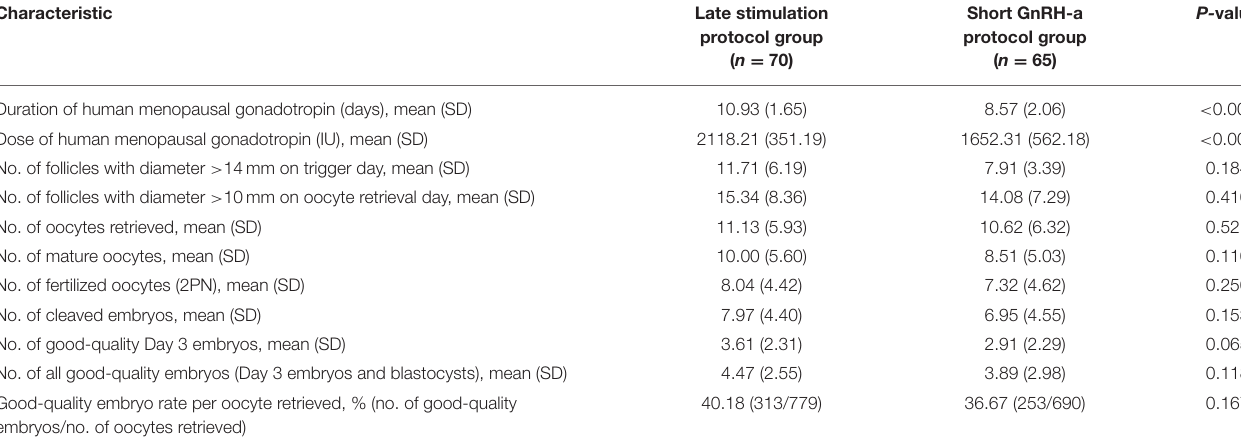
TABLE 2 | Ovarian stimulation characteristics and embryological outcomes of ovarian stimulation in the two groups. Characteristic Late stimulation